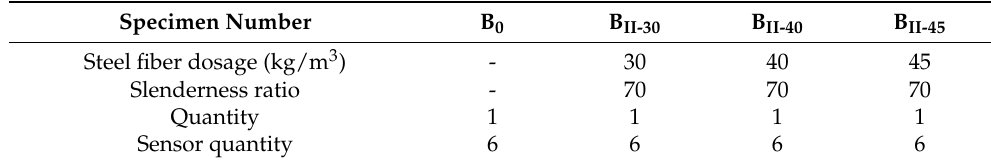
Table 5. Grouping and numbering of embedded thermocouple specimens.